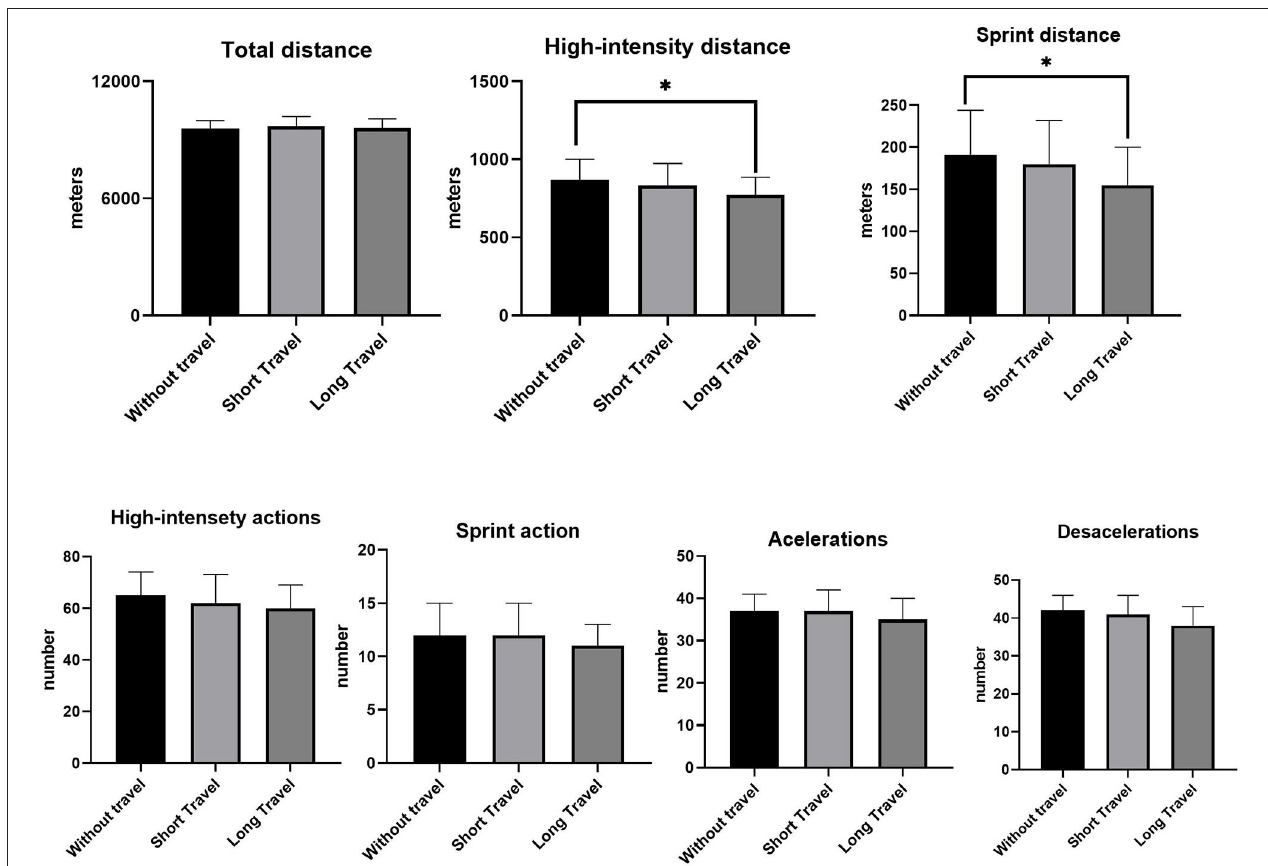
FIGURE 4 | Running performance differences according to distance traveled in Brazilian elite professional soccer players. *Without travel > Long